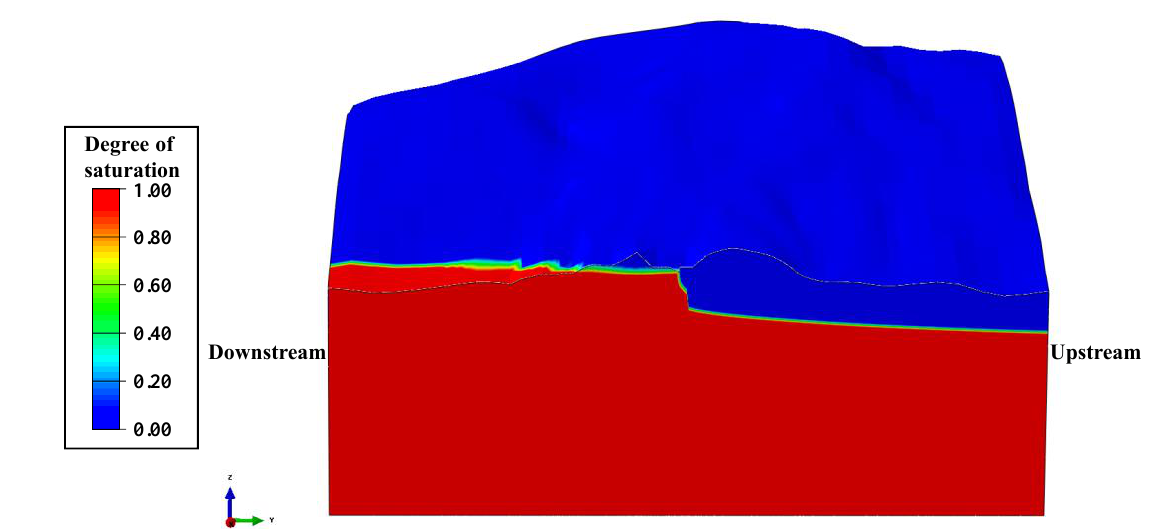
Figure 21. Numerical calculation results of rock-mass saturation in the right bank section.